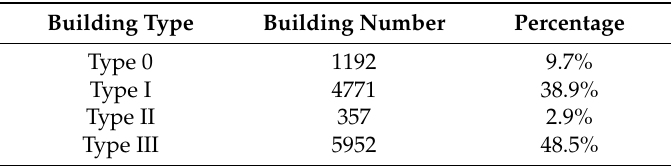
Table 2. Building number for each